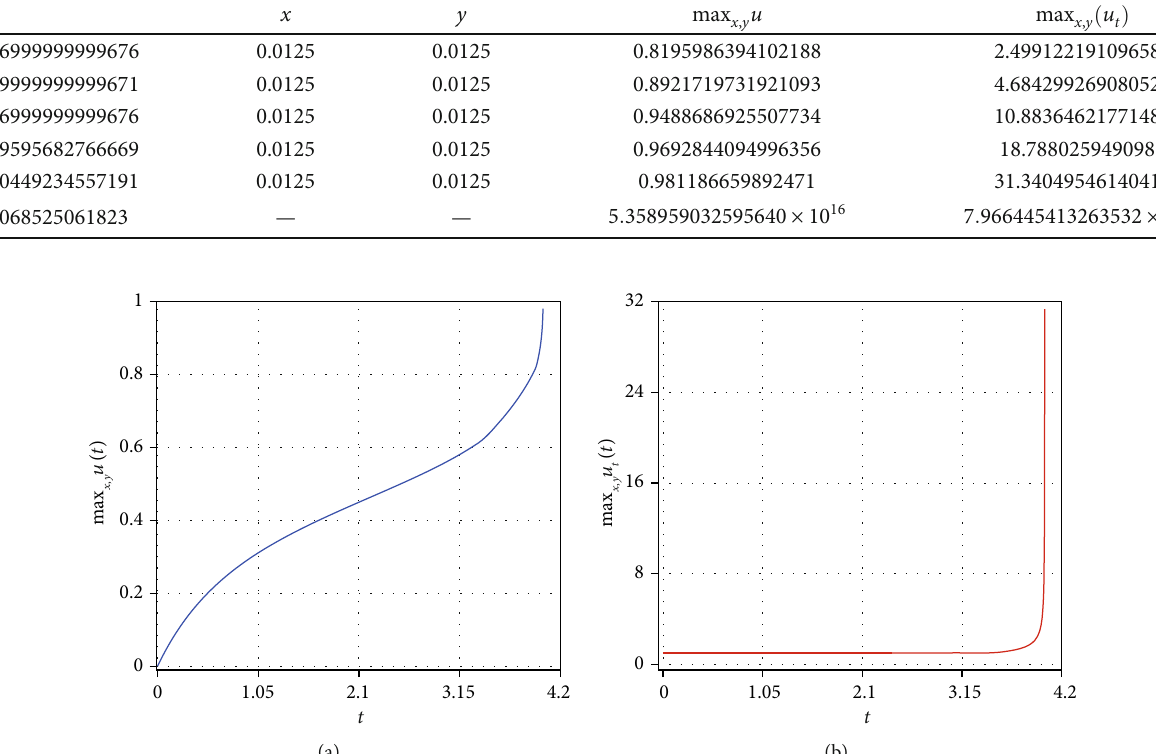
ffiffiffiffiffiffiffiffiffiffiffiffi p 11000 based on convection term b / ð α x + β y Þ .